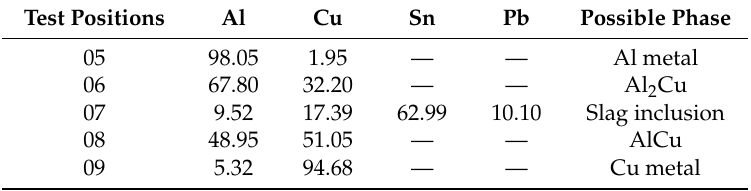
Table 2. Composition analyses of the points indicated in Figure 5